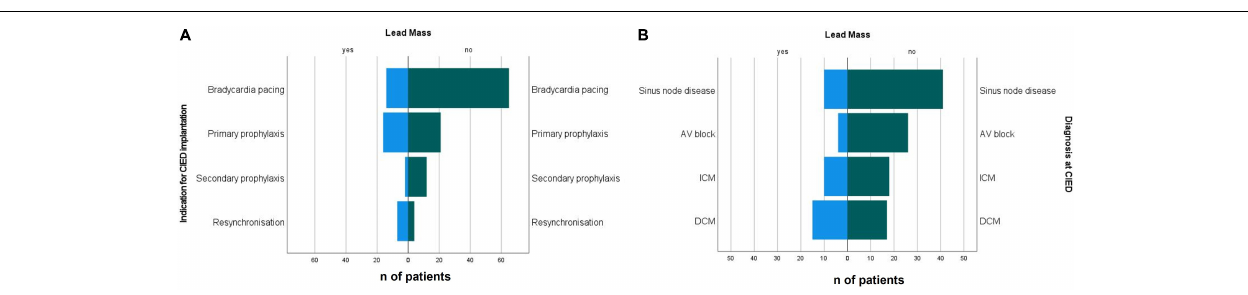
FIGURE 4 | (A) Indications for CIED implantation and (B) diagnosis at the time of implantation in patients with incidental non-infectious CIED lead masses and patients with non-suspicious leads. CIED, cardiac implantable electronic device; DCM, dilated cardiopathy; ICM, ischaemic